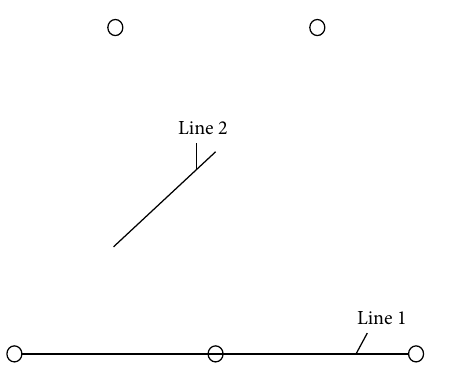
Figure 9: The structure line of the value line